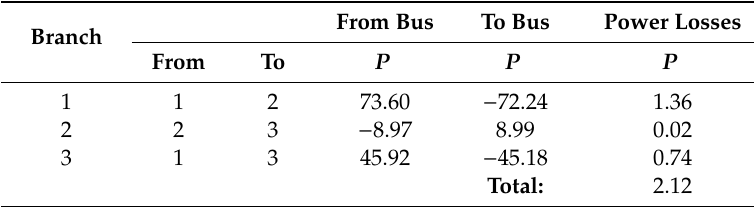
Table A29. Results of the mixed AC / DC PF calculations in Case 6-2. DC branch